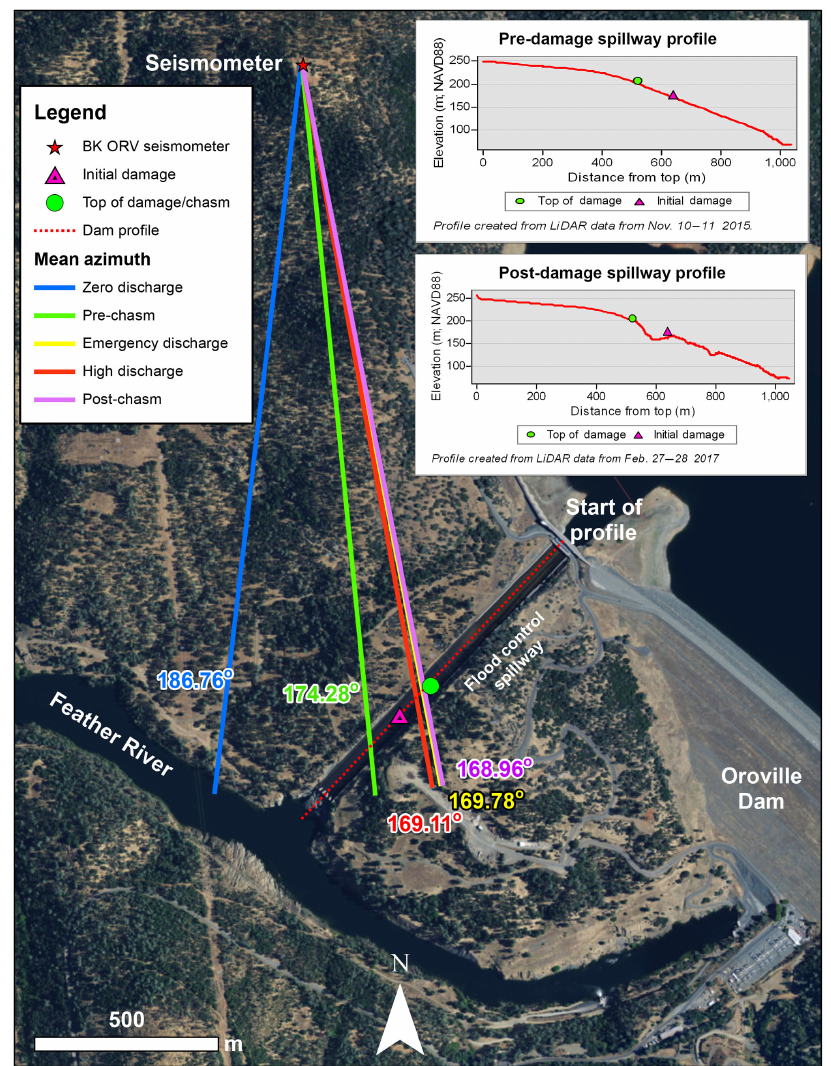
Figure 10. Mean azimuths for the five time intervals of interest mapped onto aerial imagery reveal the “Emergency discharge”, “High discharge”, and “Post-chasm” mean azimuths point to the top of the spillway damage, where a steep drop creates a waterfall. The location of the initial damage, shown as a triangle, is estimated from photographs of the damage (see Supplement). The location of the damage top, shown as a circle, is estimated from aerial photography and high-resolution lidar points collected after most of the damage